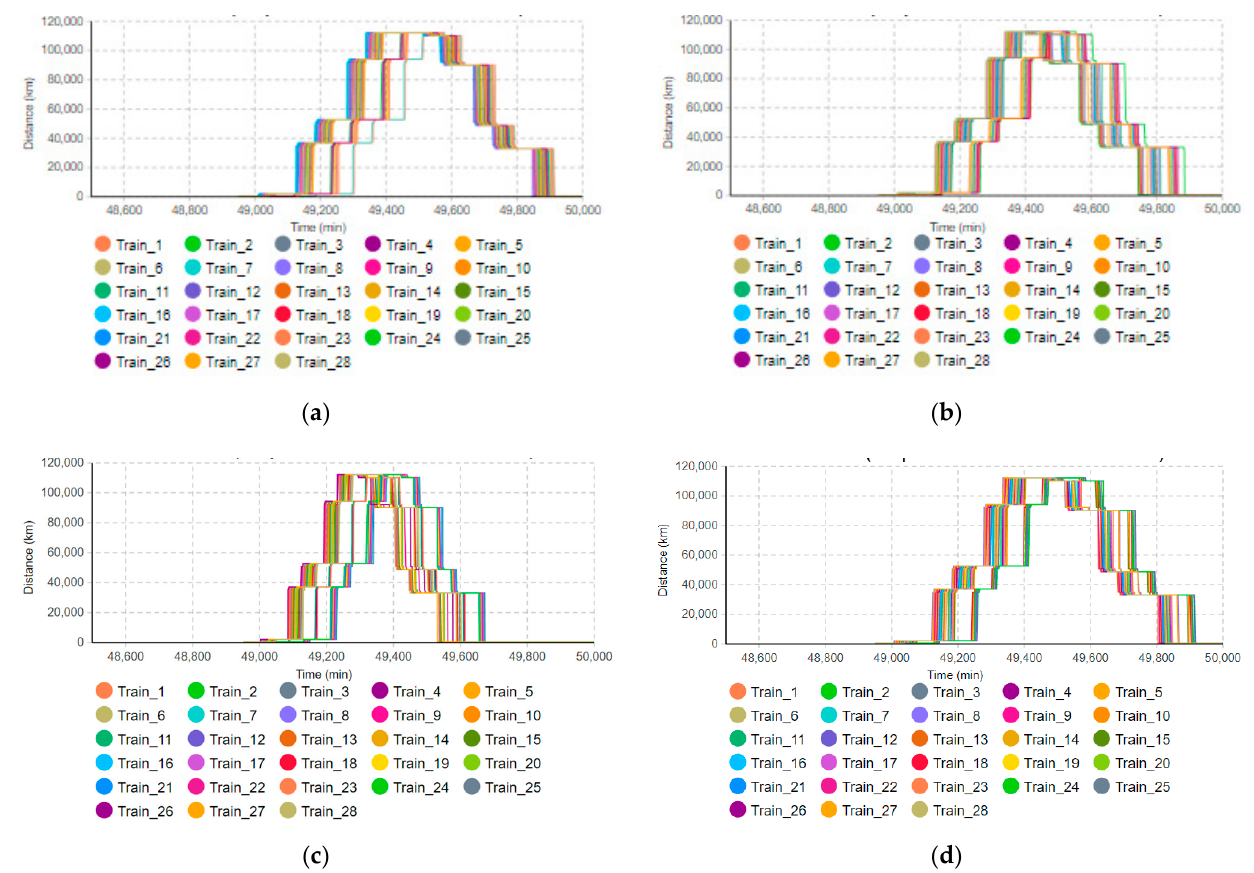
Figure 11. Timetables for different experiments: ( a ) Experiment 1; ( b ) Experiment 3; ( c ) Experiment 4; ( d ) Experiment 6.